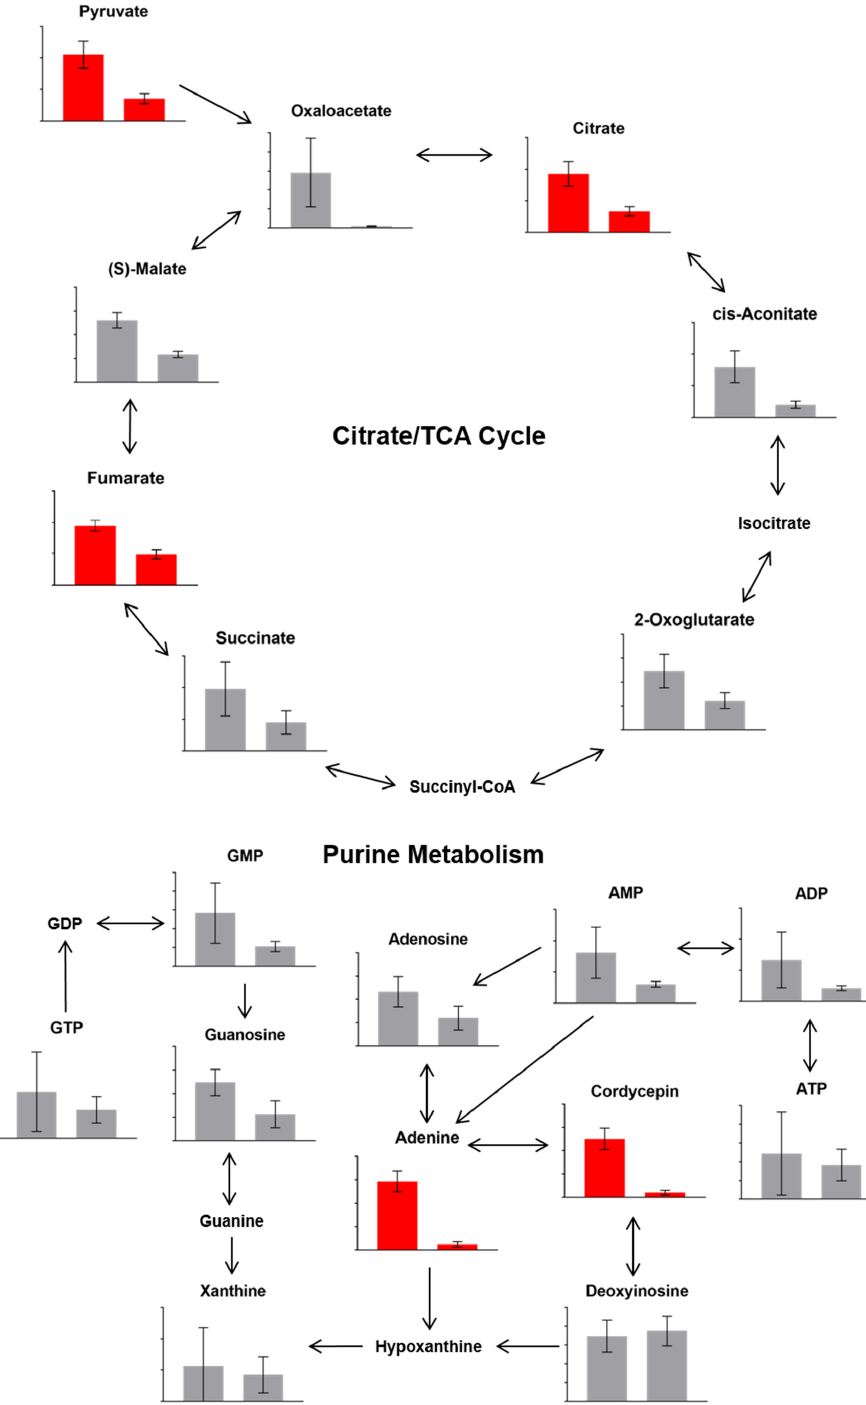
Figure 5. Metabolic pathways as described in the KEGG Database, with mean relative values of detection for parental control strain (left bar in graphs) and degenerated strain (right bar in graphs) samples. Graphs highlighted in red indicate significant differences between the parental control and degenerated strain samples, as determined by both t-test with FDR correction, and having VIP values > 1. Error bars show 95% confidence intervals. Arrows between metabolites present pathway